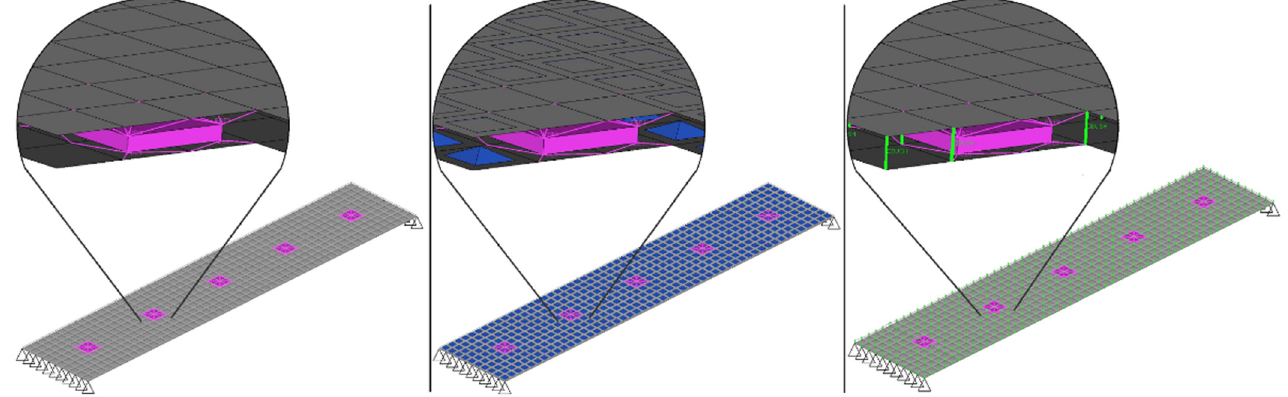
Figure 4. FE test models: without contact elements ( left ), with nonlinear contact elements ( center ) and with linear adjusted contact elements ( right ).